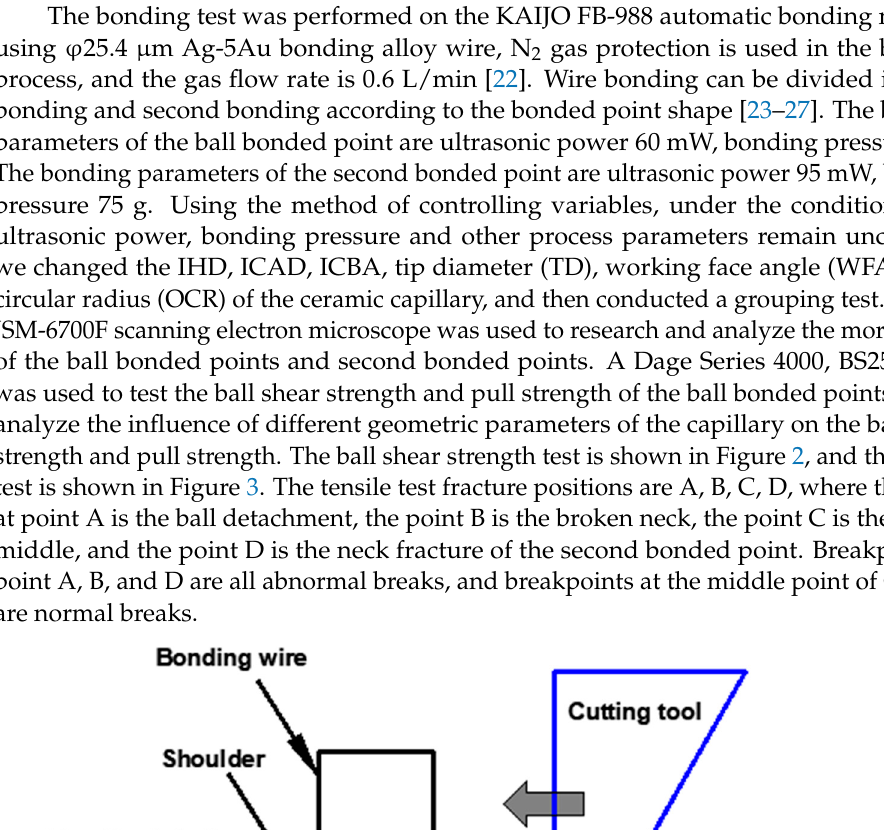
Figure 3. Schematic diagram of tensile test and breaking position. 3. Results 3.1. The Research on the Influence of IHD on the Morphology of Bonded Point A free air ball (FAB) is formed by bonding alloy wire under the action of ball burn- ing current [28], and the diameter of the FAB is generally 2–3 times of wire diameter [29– 33]. The diameter of the FAB is 66.76 μ m (2.63 times the diameter of alloy wire) in the test, which meets the test requirements. As shown in Figure 4, the FAB changes into the shape of the ball bonded point formed under the action of bonding power, pressure and tem- perature by force of a ceramic capillary. Figure 5 shows the morphology of the ball bonded points with the different IHD. When the IHD is 33 μ m, the shape of the neck of the ball bonded point is regular and symmetrical, and the perpendicularity with the bonded point is better; the ball bonded point has a thin neck and irregular shape when the IHD is 26 μ m. The neck of the ball bonded point deviates greatly from the center when the IHD is 41 μ m.